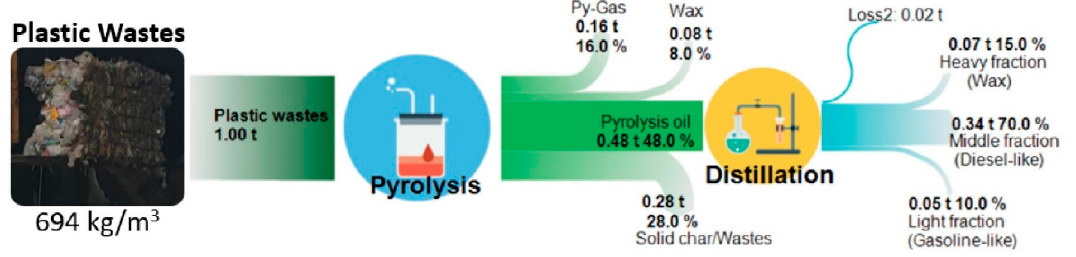
Figure 3. Plastic waste pyrolysis process mass balance from Lee et al., reproduced with permission [108].